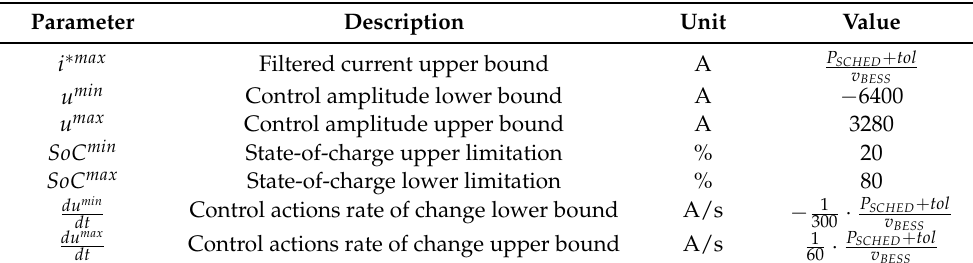
Table 2. Limitations assigned to the